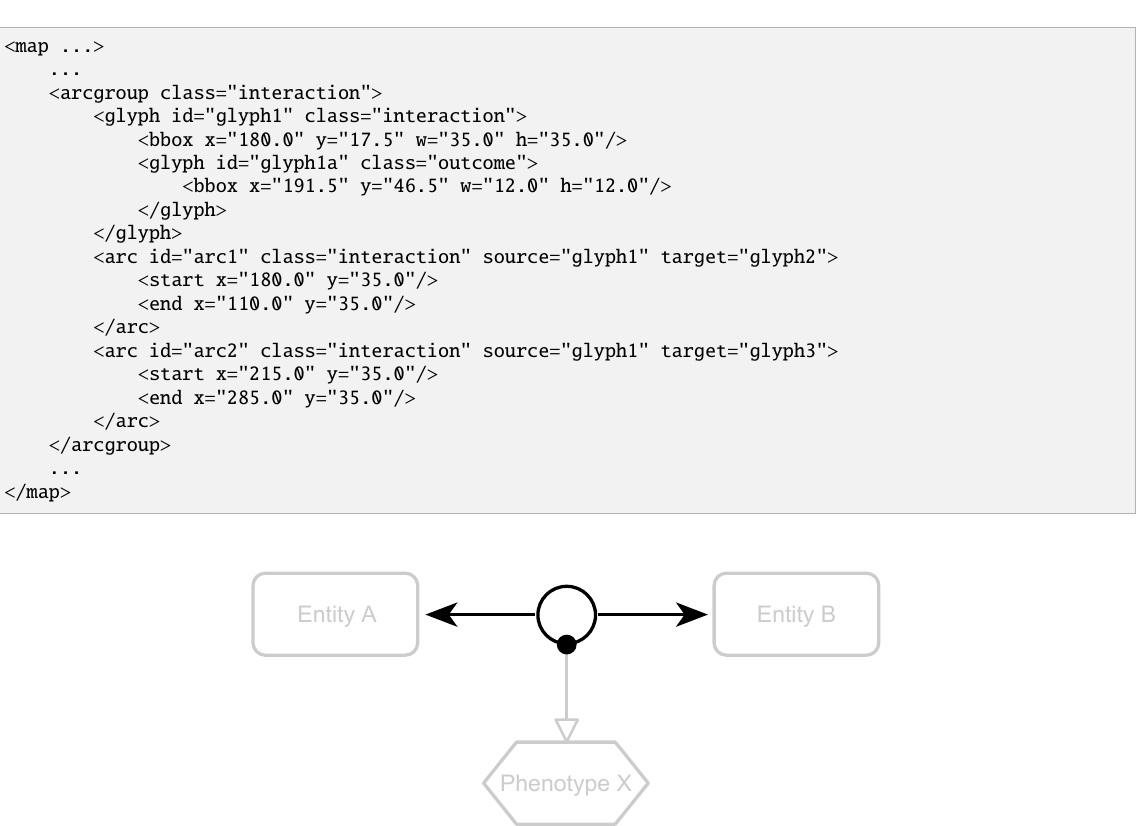
Figure 26: Visual representation of an ArcGroup of class interaction with one Glyph of class interaction and two Arc s.